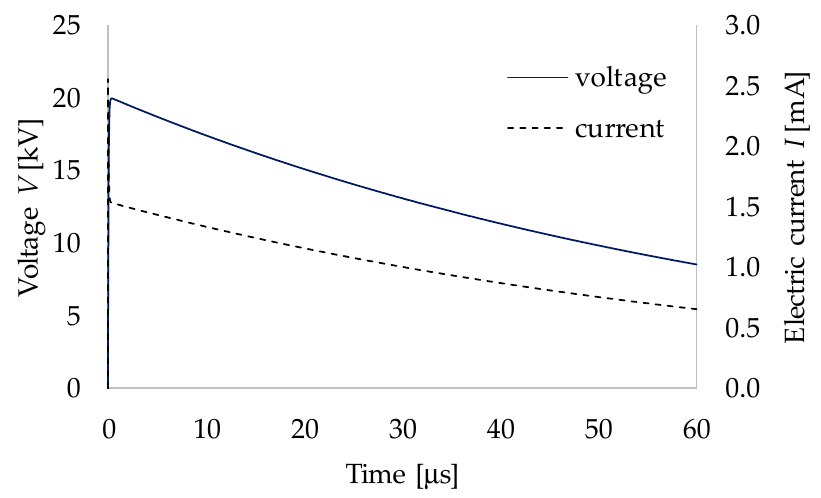
Figure 4. Applied voltage used in this simulation work and electric